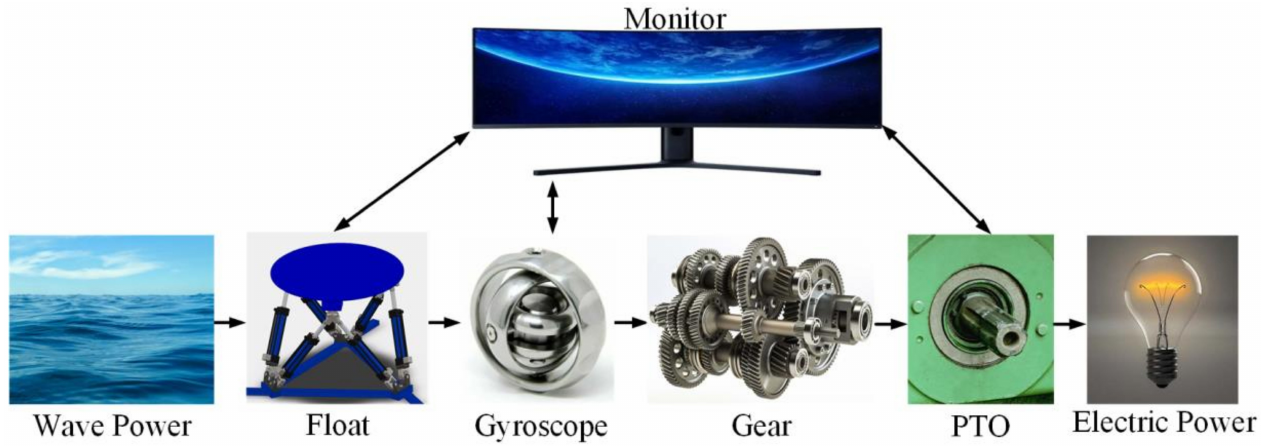
Figure 2. Principle of